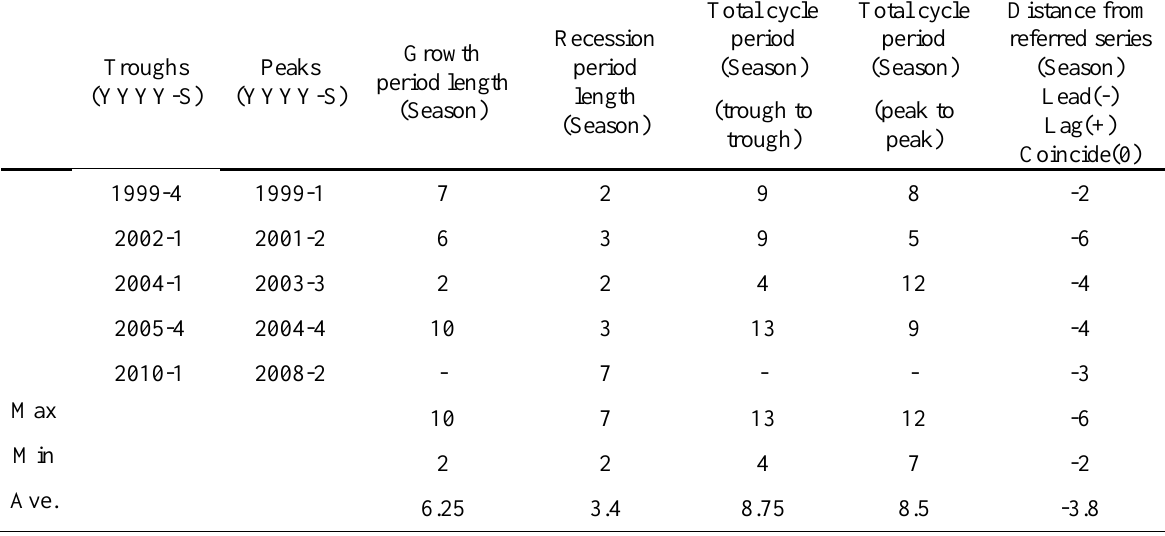
Table 2. Turning points of Imports value and its comparison with reference series